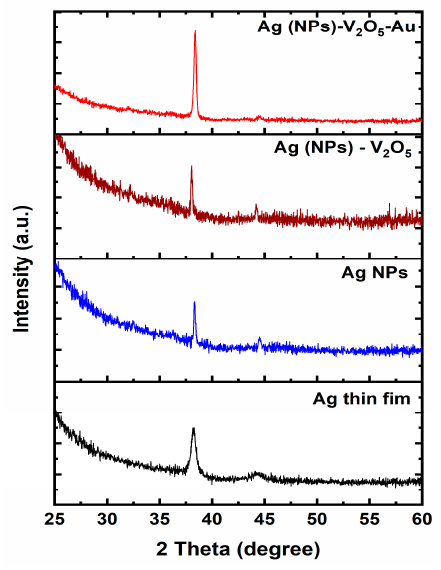
Figure 2. XRD pa tt erns of Ag NPs/V 2 O 5 /Au NPs, Ag NPs/V 2 O 5 , Ag NPs, and Ag NPs thin fi lm. Figure 2. XRD patterns of Ag NPs/V 2 O 5 /Au NPs, Ag NPs/V 2 O 5 , Ag NPs, and Ag NPs thin